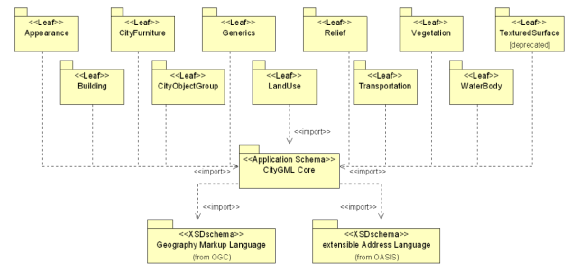
Figure 2 : Module of CityGML and their scheme dependencies (Source: Groger et al.,